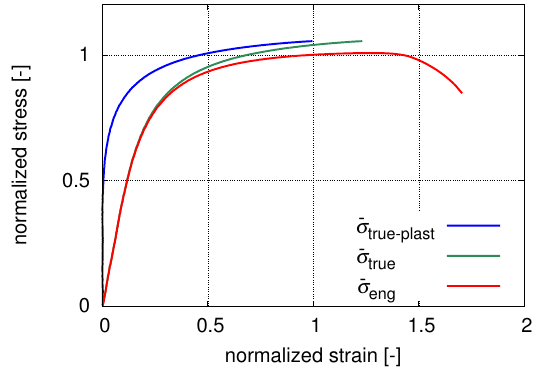
Figure 18. Engineering and true stress-strain normalized with respect to the mean ultimate tensile strength and mean uniform strain, respectively [33].